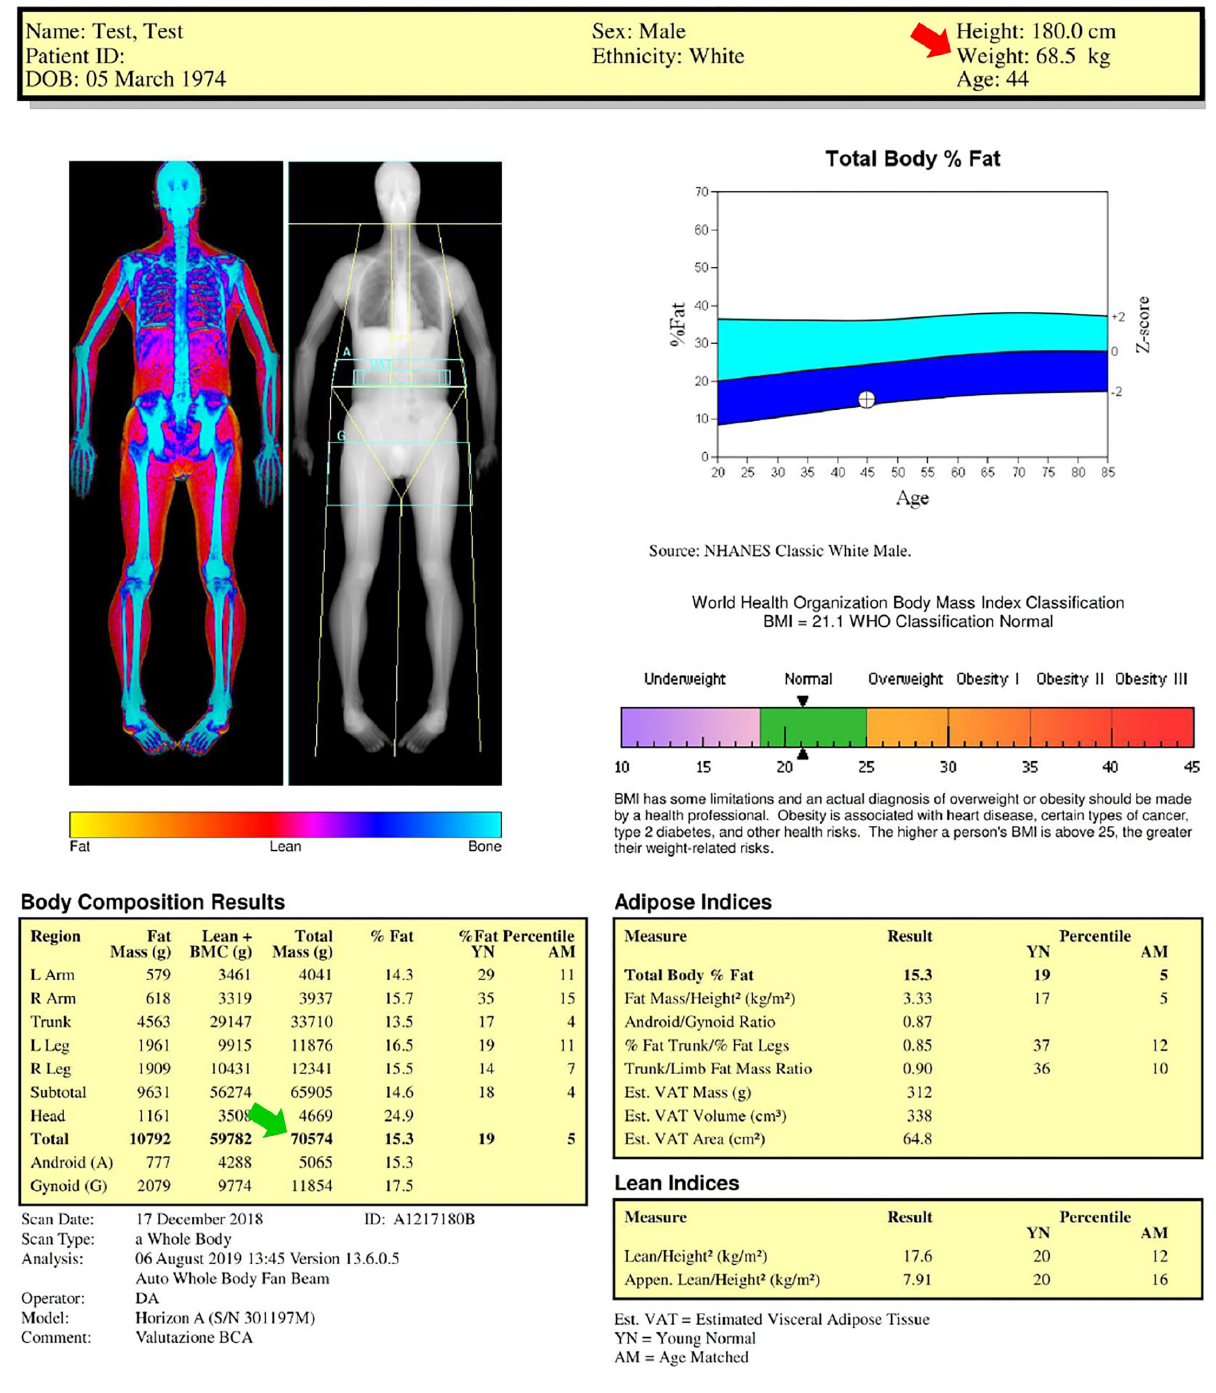
Frontiers in Rehabilitation Sciences | www.frontiersin.org